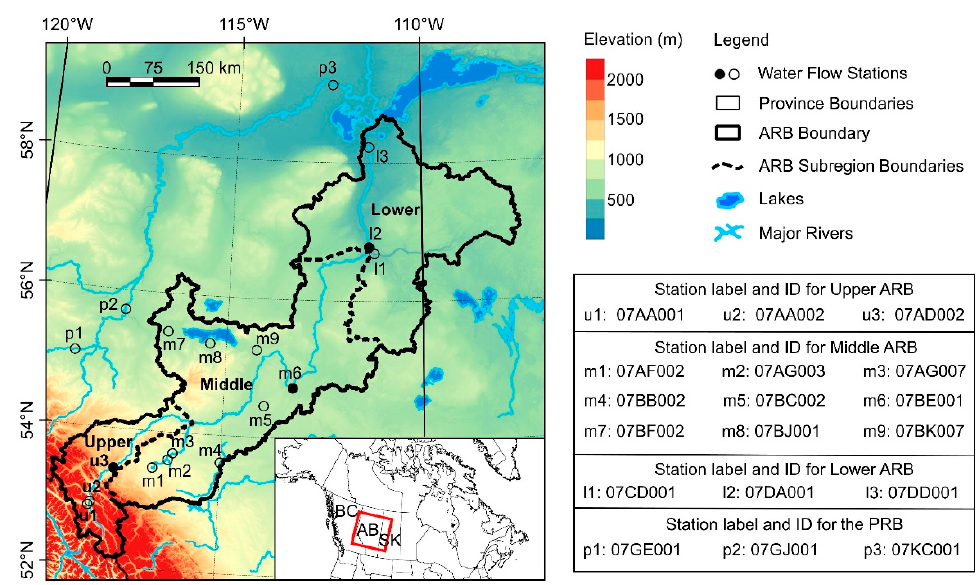
Figure 1. Map of the ARB and its location and topography, and the ID and locations of the waterflow gauging stations used in this study. Hydrometric stations marked with closed circles were considered to represent the subregion in which they lie because they are located along the Athabasca River and provided long-duration and continuous flow measurements. Note that l2 was the only station that provided continuous historical records since 1956 as compared to other stations in the lower ARB; see the Supplementary Materials. Stations p1, p2, and p3 are in the PRB. Table 1. Gauging station attributes in the ARB and surrounding area. Letters u, m, and l in the first column refer to the upper, middle, and lower ARB, respectively. Additionally, letter p in the first column refers to the PRB.